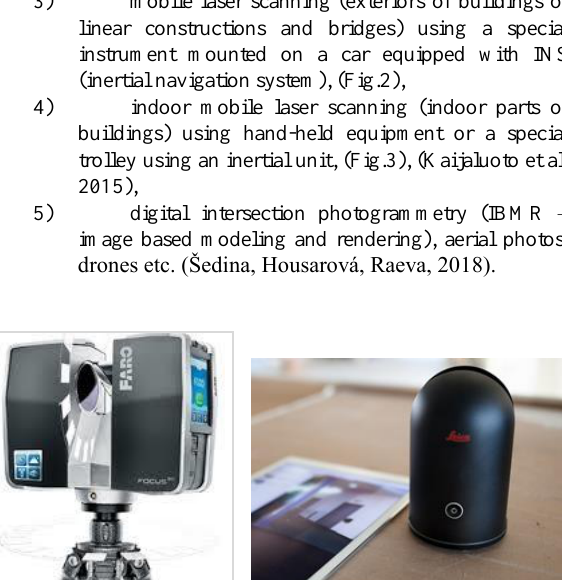
Figure 3. Indoor laser scanners (GEO Slam) Zeb REVO (left), Faro